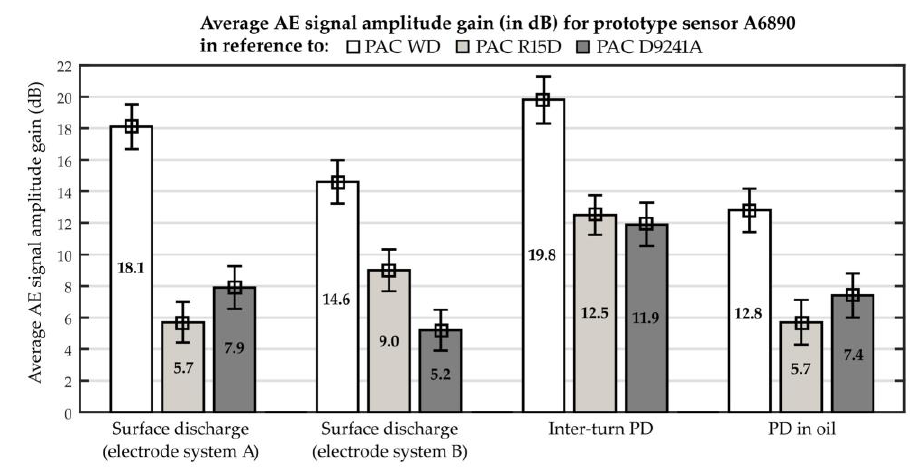
Figure 23. Average AE signal amplitude gain for prototype sensor A6890 in reference to commonly used commercial sensors: PAC WD, PAC R15D, and PAC D9241A.